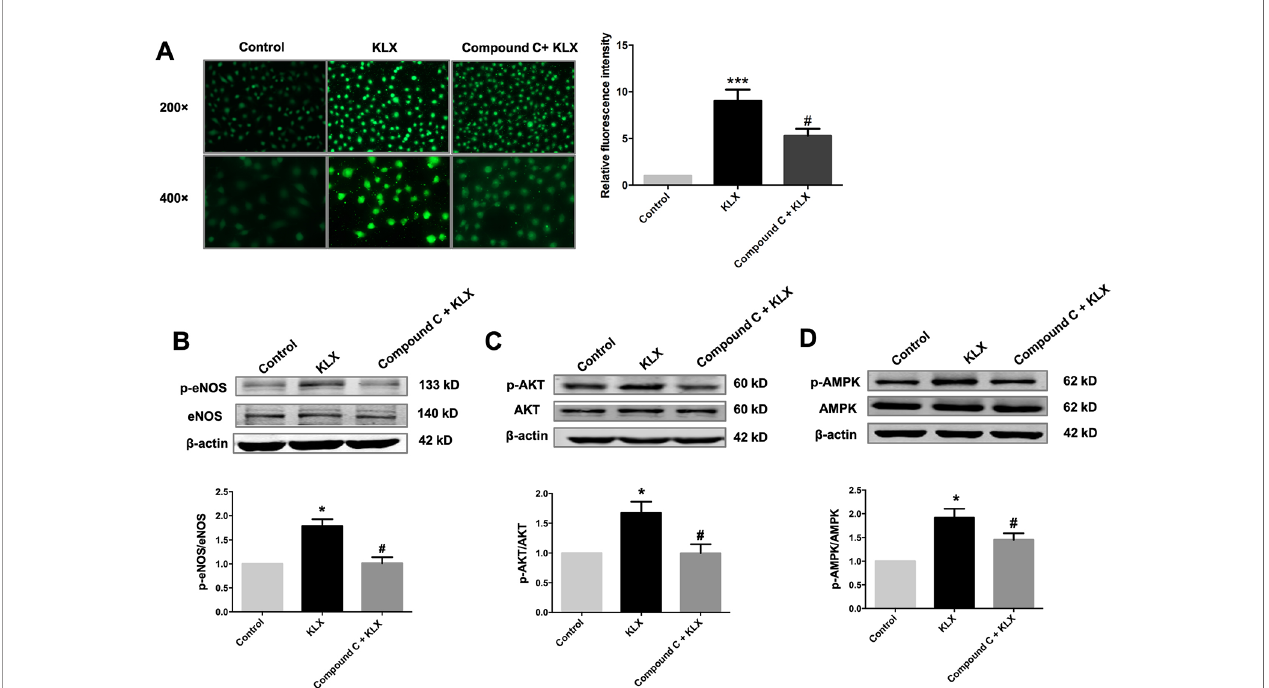
FIGURE 5 | KLX increases NO release through activating the AMPK-AKT pathway. (A) Typical examples (left panel) and statistical data (right) of DAF-FM DA fl uorescent staining of NO showing the inhibitory effect of compound C (10 µM) on KLX-induced NO production in HUVECs. *** p < 0.001 vs control, # p < 0.05 vs KLX, n = 5. (B) Inhibitory effect of compound C on KLX-induced phosphorylation of eNOS protein. * p < 0.05 vs control, # p < 0.05 vs KLX, n = 6. (C) Inhibitory effect of compound C on KLX-induced phosphorylation of AKT protein. * p < 0.05 vs control, # p < 0.05 vs KLX, n = 6. (D) Inhibitory effect of compound C on KLX-induced phosphorylation of AMPK. * p < 0.05 vs control, # p < 0.05 vs KLX; n =